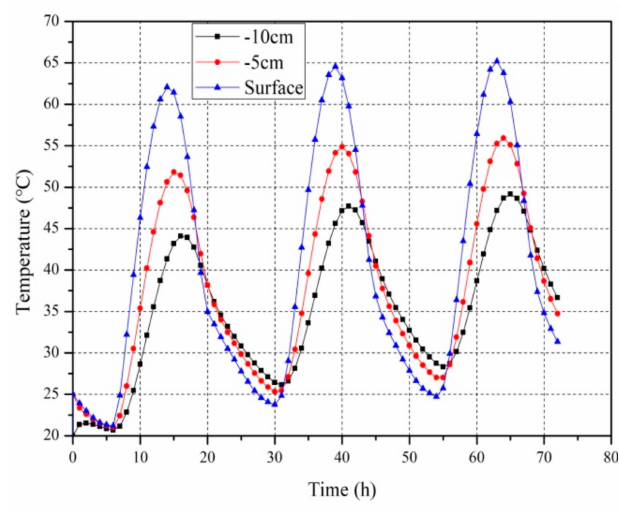
Figure 9. Asphalt concrete facing temperature calculation results.